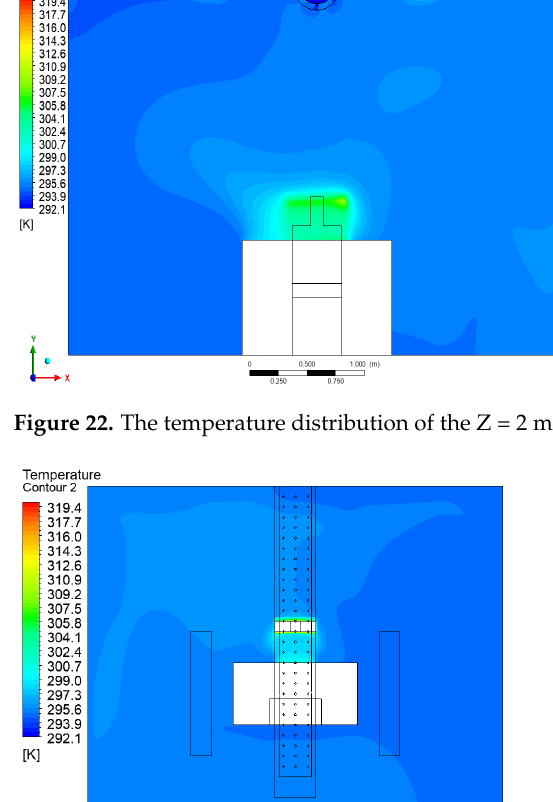
Figure 21. The temperature distribution of the X = 2 m section.